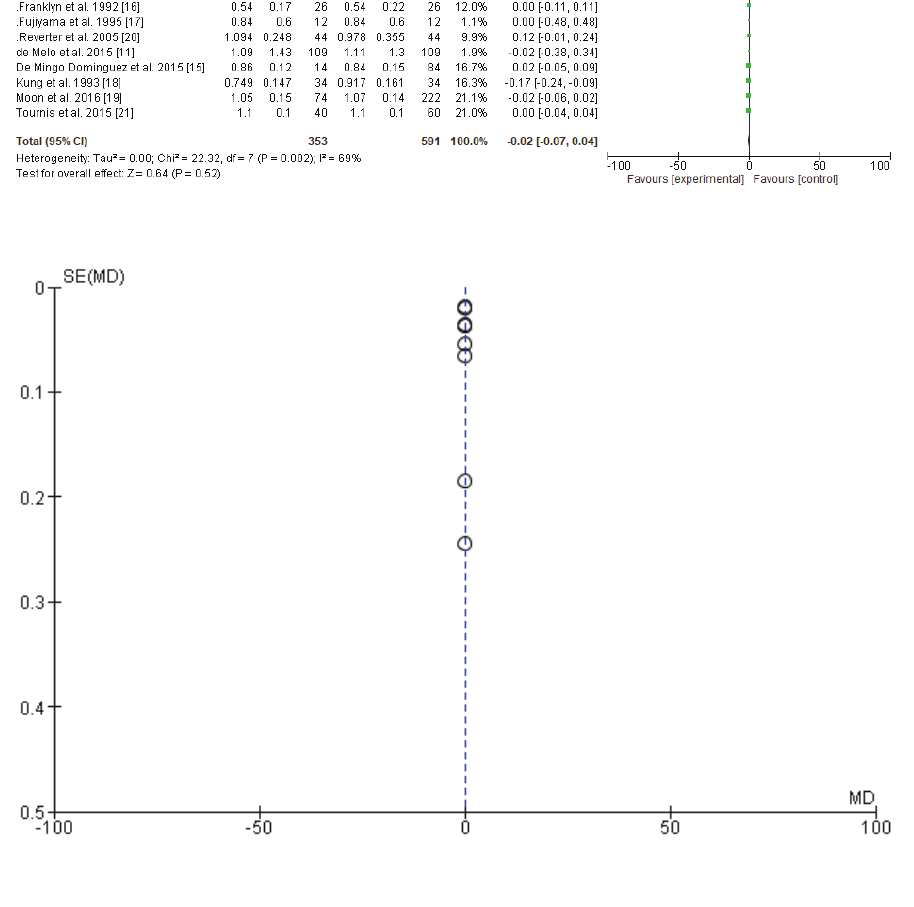
Figure 4 : TSH suppression and bone mineral density among postmenopausal women lumbar